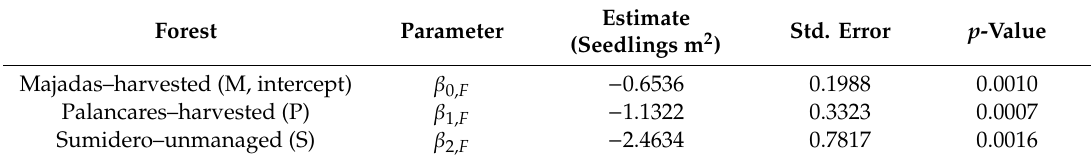
Table 5. Parameter values of Equation (3) (binomial part of the zero-inflated model), estimates, standard errors and p -values to estimate the number of recruits (forest effect) in three Spanish black pine forests of Cuenca Mountains (Spain).